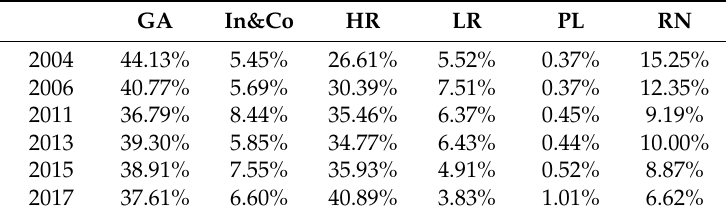
Figure 9. Land use classifications obtained for years 2004, 2006, 2011, 2013, 2015 and 2017. GA, green area; In&Co, industrial and commercial areas; HR, high-density residential areas; LR, low-density residential areas; PL, parking lot; RN, road network. Table 2. Land use constitution of the study area from 2004, 2006, 2011, 2013, 2015 and 2017. GA, green area; In&Co, industrial and commercial areas; HR, high-density residential areas; LR, low-density residential areas; PL: parking lot; RN: road